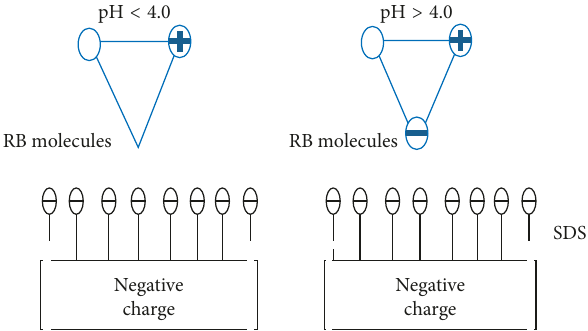
Figure 6: The suggested mechanism of RB binding to the modified